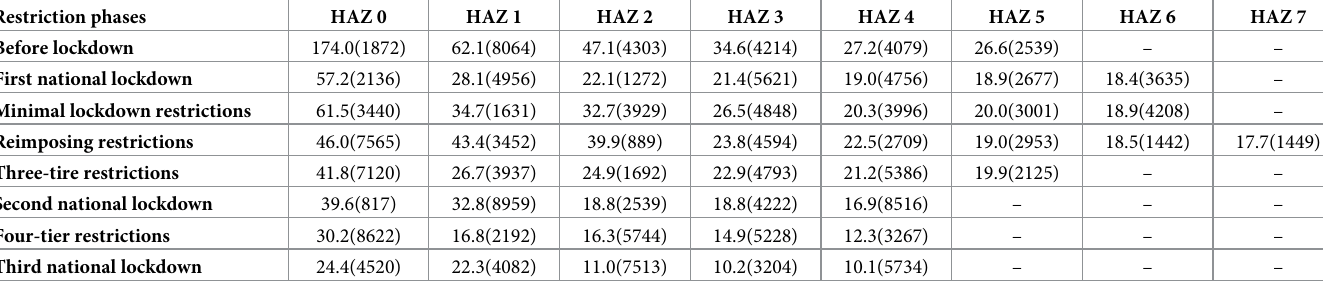
Table 2. The Daily average footfall volumes and OA numbers of HAZs in eight policy restriction phases.